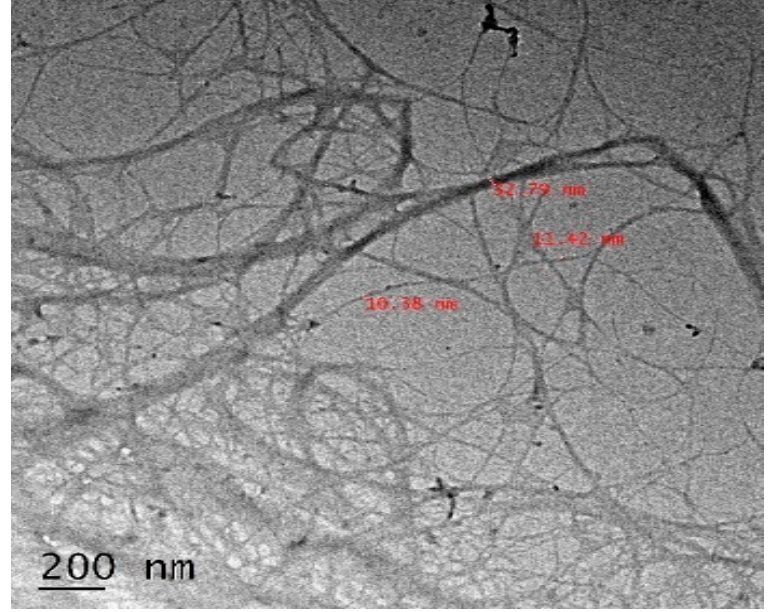
Figure 4. Transmission Electron Microscopy (TEM) image of CNF isolate from Cuscuta reflexa plant.